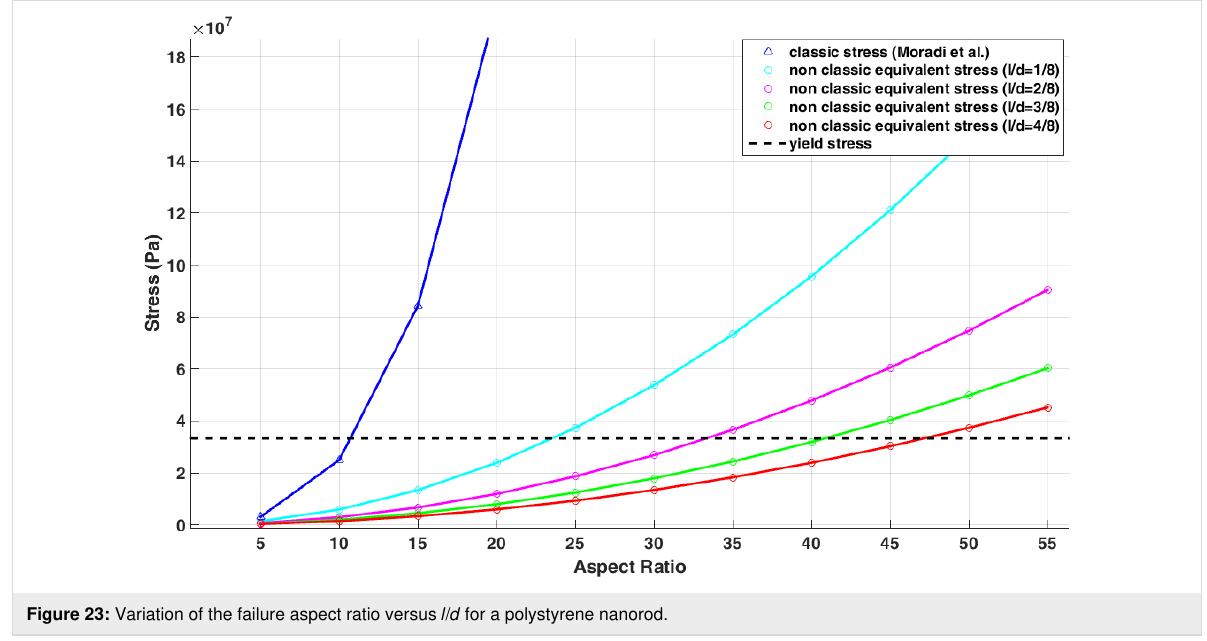
Figure 23: Variation of the failure aspect ratio versus l / d for a polystyrene nanorod.